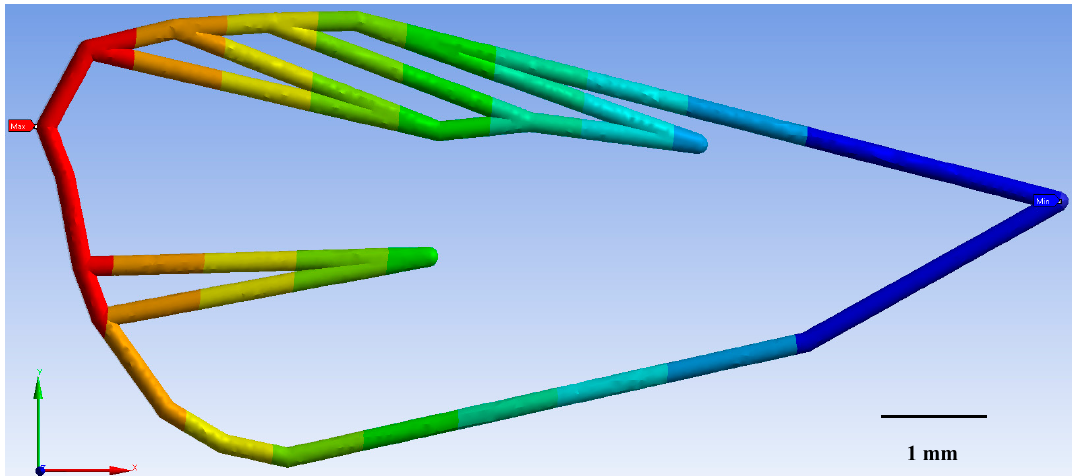
Figure 6. Codling moth from the ecological populations exhibited a maximum deformation (red area) of 0.0118 mm around landmark 8 (Figure 1) for a maximum wind speed of 4.2 m/s − 1 . The minimal deformation of 0.0013 mm was concentrated around landmark 17 (light blue area on figure).